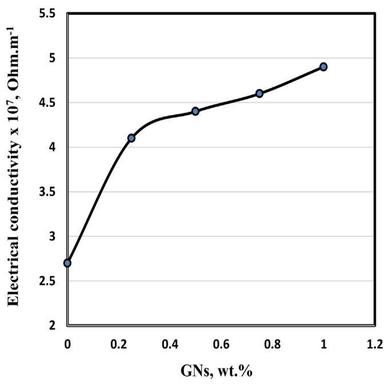
Electrical conductivity of Cu/WC-TiC-Co/GNs nano composites.